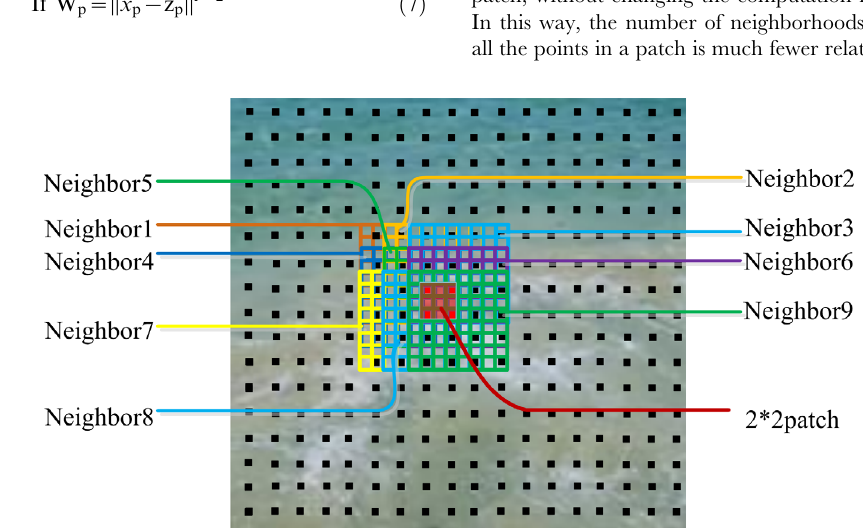
Figure 6. Neighborhood number: An example of replacing pixel-based computation with 2*2 patch.